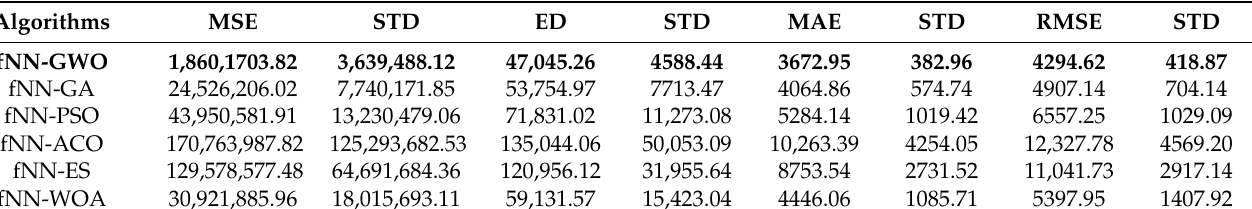
Table 6. A comparison between fNN-GWO error forecasting results for total daily load consumption, and other meta- heuristics methods.